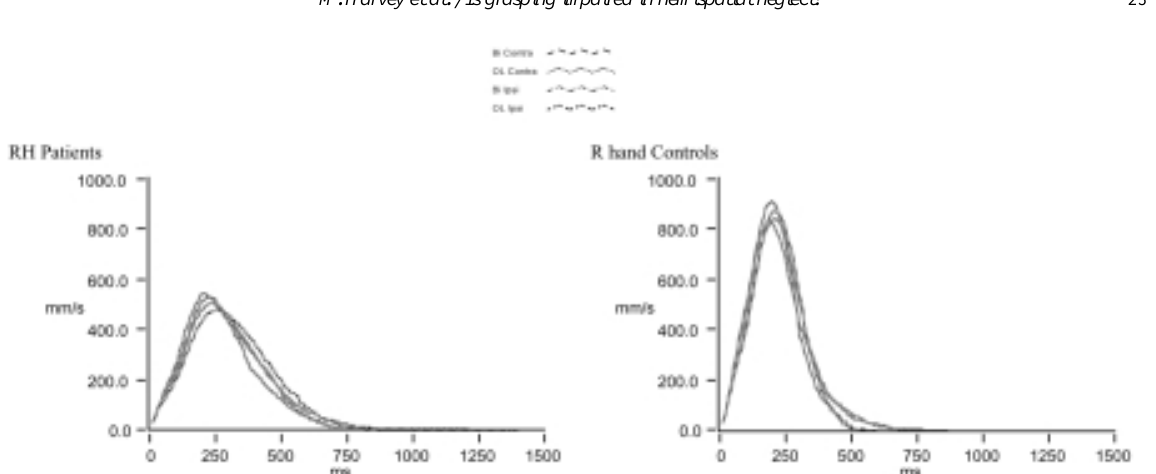
Fig. 4. Mean Velocity profiles for control subjects and RCVA patients (RH patients) plotted separately for viewing condition (Bi = Binocular, OL = Open Loop) and hemispace (Contra = Contralateral, Ipsi =